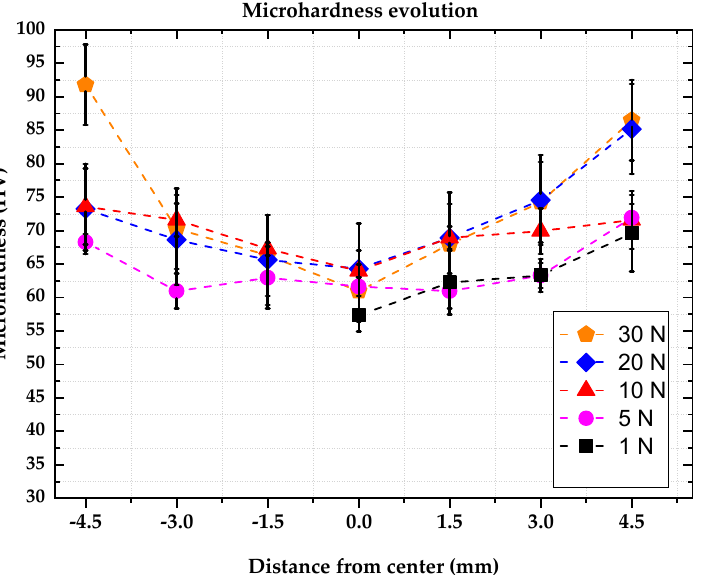
Figure 9. Microhardness values determined from samples processed by HPT from 0 to 30 N under a pressure of 5 GPa.